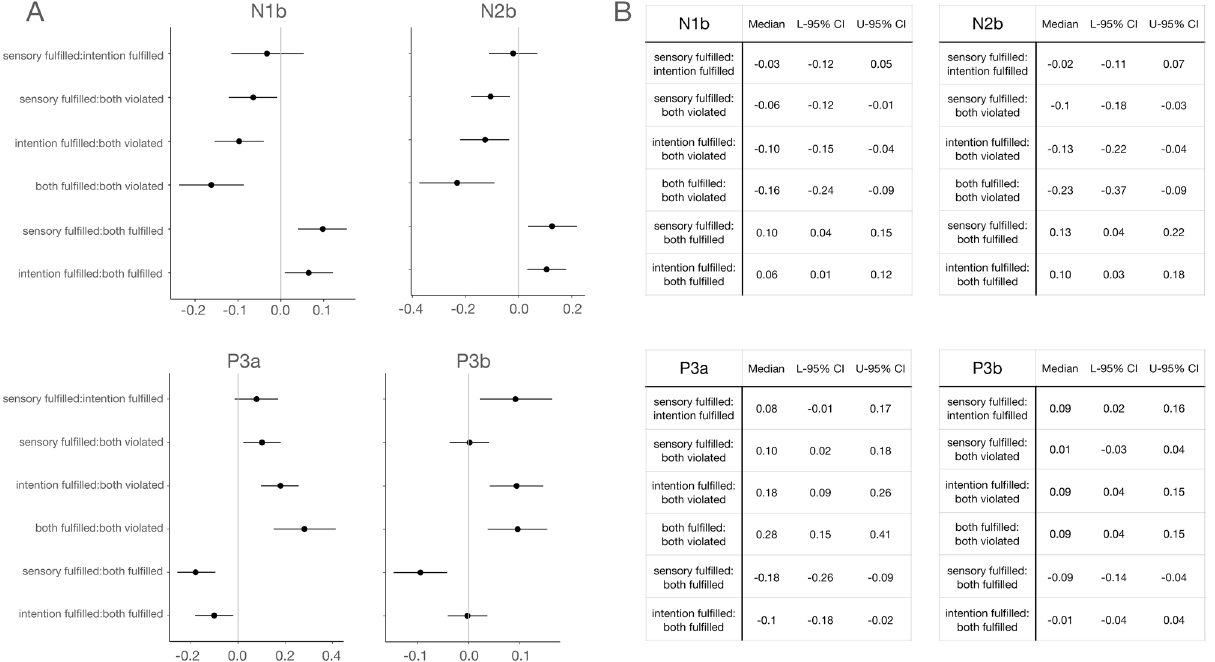
Figure 6. Medians and credible intervals (95%) of planned pairwise comparisons of condition estimates, calculated with the function ‘hypothesis’ in the R package ‘brms’, for components in which significant effects were observed. Intervals that do not include zero have the denoted probability to be a true effect, i.e., differences between the indicated factors to be significant. Note that the labels have been simplified for the sake